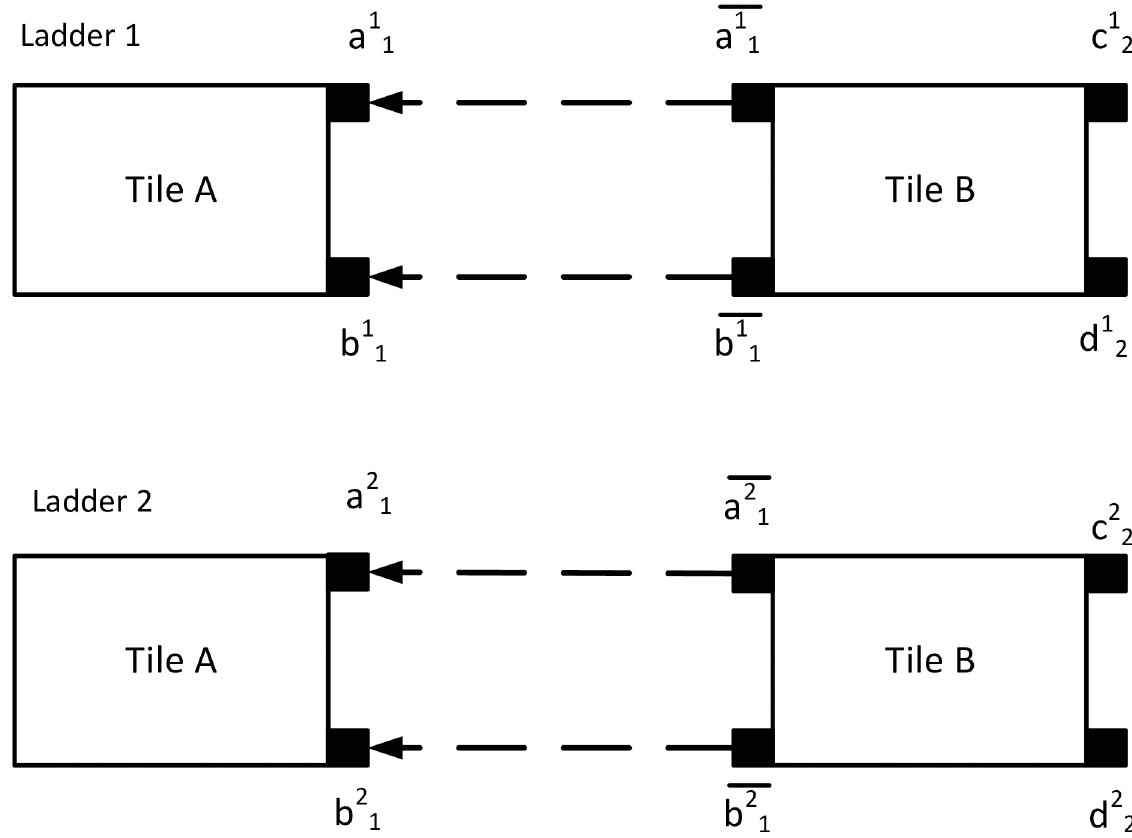
Fig 1. Matching glue rules. An example represents the matching glue rules. Here, the assembly system has four tiles of two tile types(tile A and tile B). The first tile A has glues f a 1 and the other tile has glues f � a 2